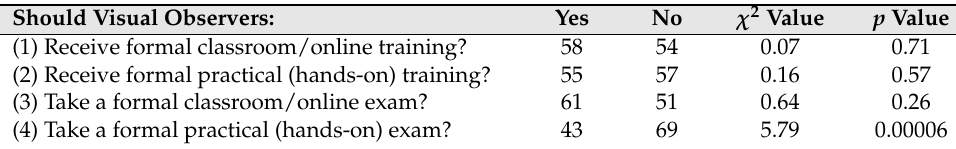
Figure 1. Phase 2: Bar graph depicting participants’ reported roles in aviation; the total number of included participants is 112. The label ‘frequent flyer’ applies to pilots or passengers and the acronym ‘ATC’ stands for air traffic controller. Categories were not mutually exclusive. Table 1. Yes/No counts for survey responses and results of statistical ( χ 2 ) tests in Phase 2. A 2 × 2 contingency table was constructed for each question, comparing the observed number of Yes and No responses to the expected values of 56 Yeses and 56